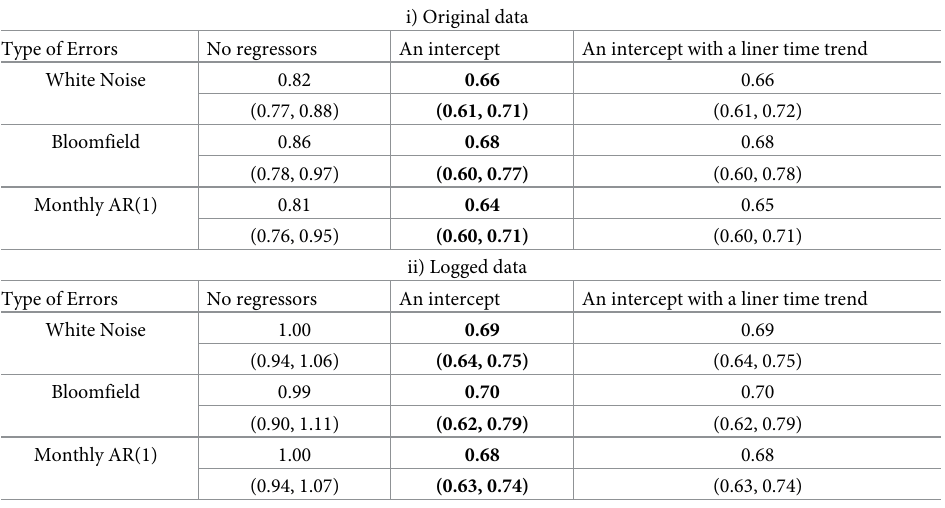
Table 1. Estimates of the differencing parameter: 1976m1 –